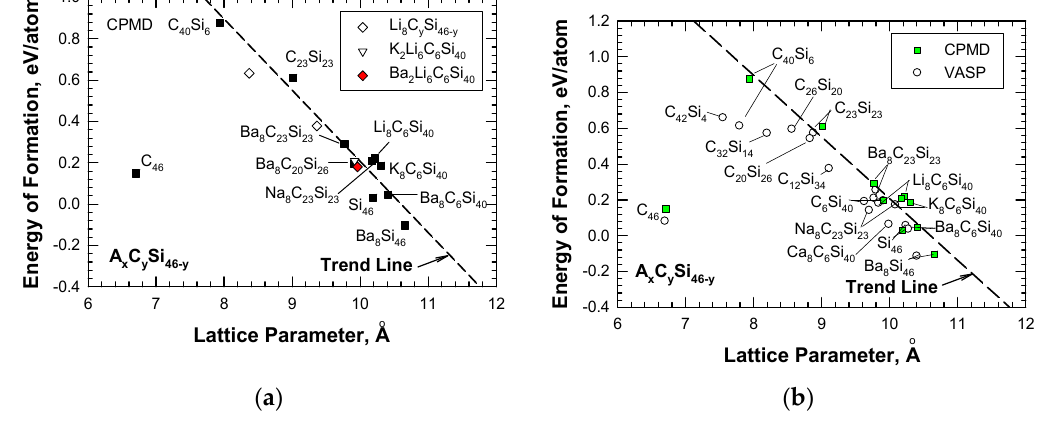
Figure 5. Energy of formation computed via CPMD and VASP for various intermetallic clathrates based on the A x C y Si 46-y compositions with the hybrid C y Si 46-y framework: ( a ) CPMD computations and ( b ) comparison of CPMD and VASP computations. From Chan et al. [8]. Reprinted with permission from Springer.